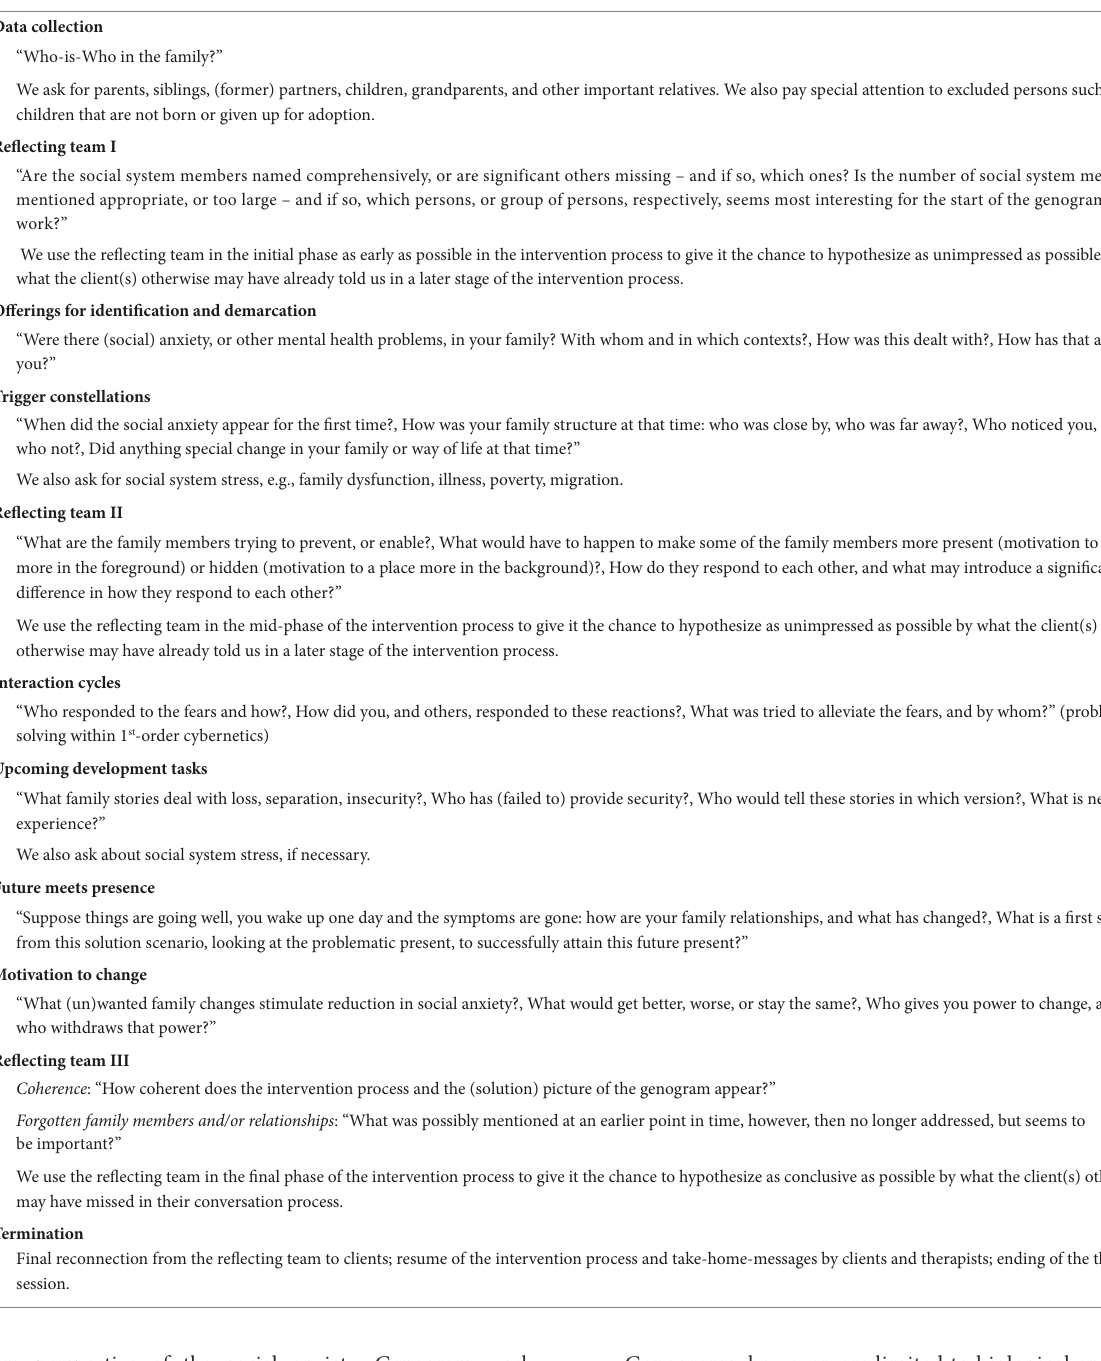
TABLE 5 Genogram interview in the context of social anxiety (Schweitzer et al., 2020). Process of a genogram